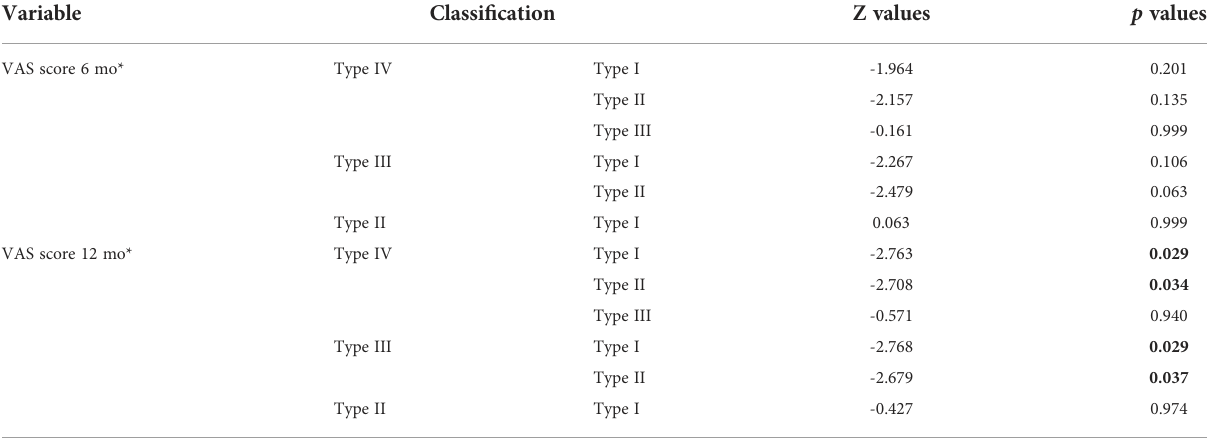
Bold values means p< 0.05.